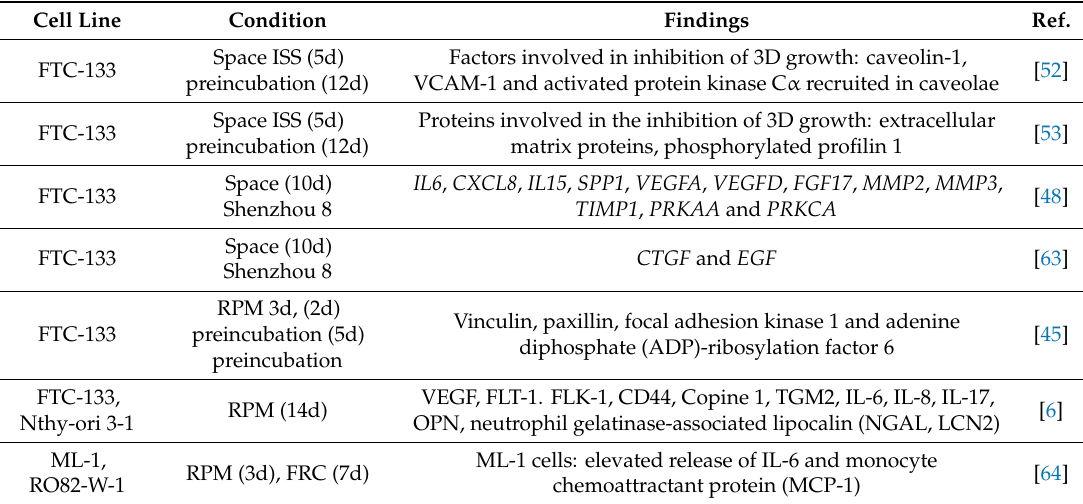
Table 1. Selected articles addressing the mechanisms of spheroid formation of thyroid cancer cells exposed to real or simulated µ g .